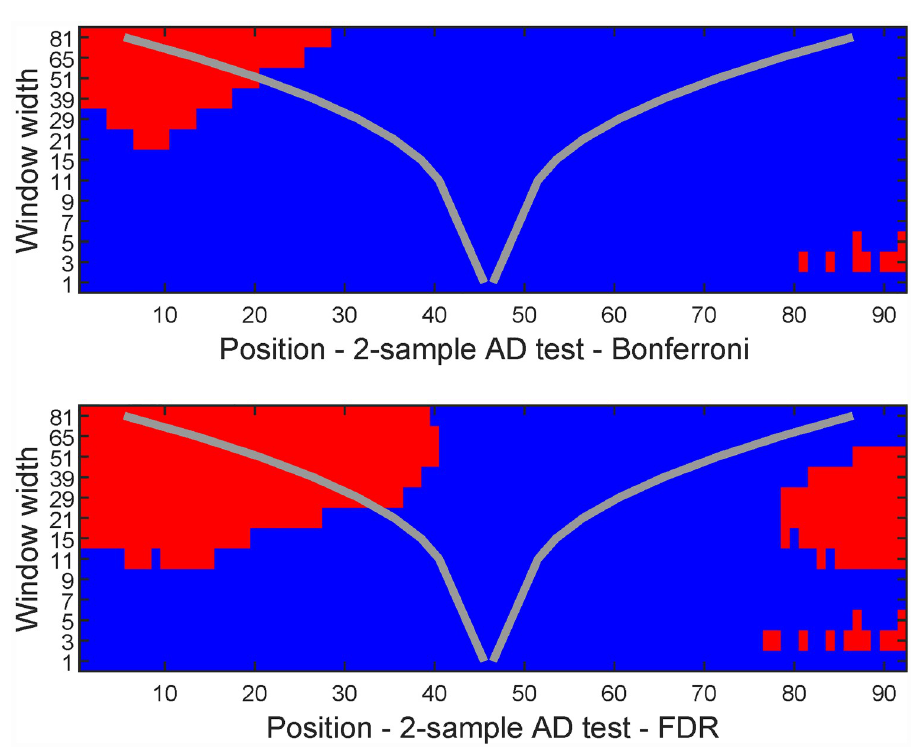
Fig 11. Significance maps from comparing the temperature data of Ferder and Fornebu with the scale-space method. See Fig 3 for annotation details.